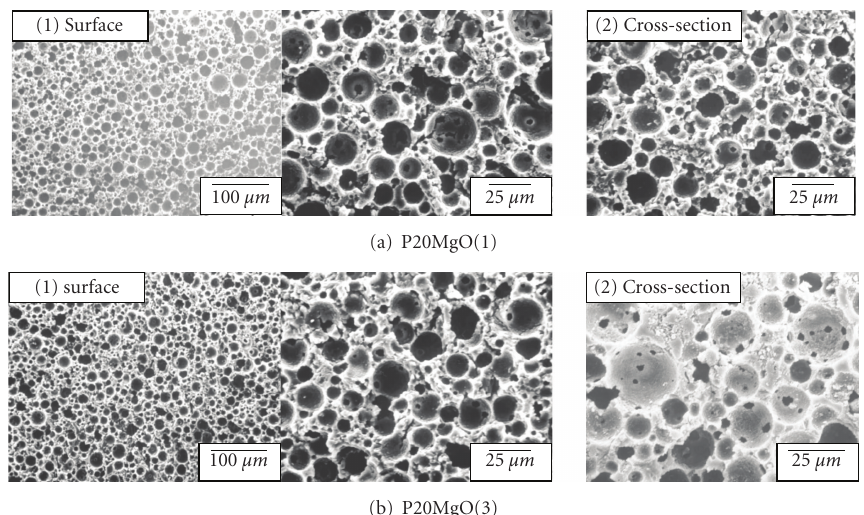
Figure 4: SEM photographs of (a) P20MgO(1) and (b) P20MgO(3).